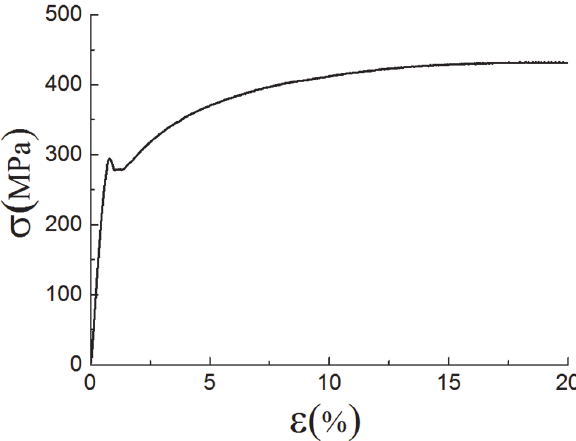
Figure 2: Material constitutive curves